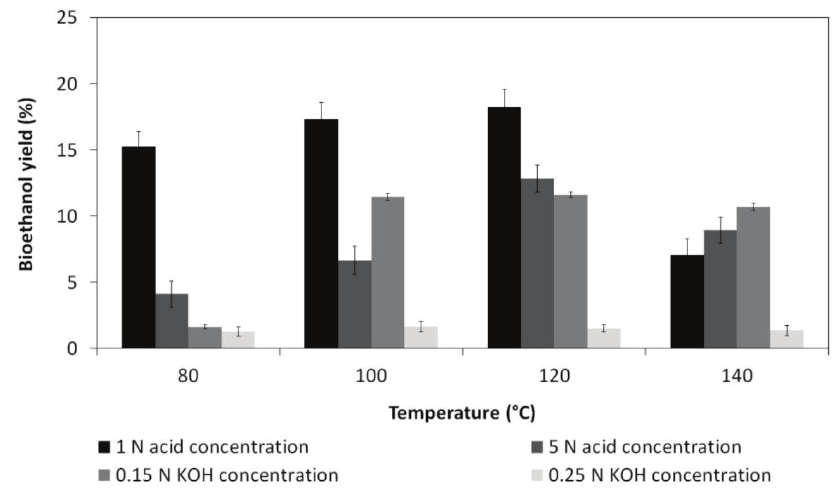
Fig. 3 – Effect of pre-treatment temperature on bioethanol yield (0.15 N and 0.25 N KOH, 1 N and 5 N H SO , pre-treatment time: 60 2 4